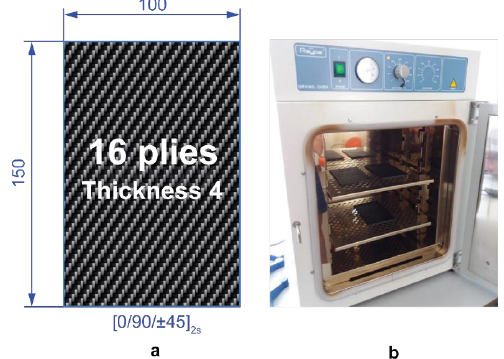
Figure 1. ( a ) Standard impact specimens according to ASTM D7136 recommendations. ( b ) Programmable oven used for the thermal ageing treatments.